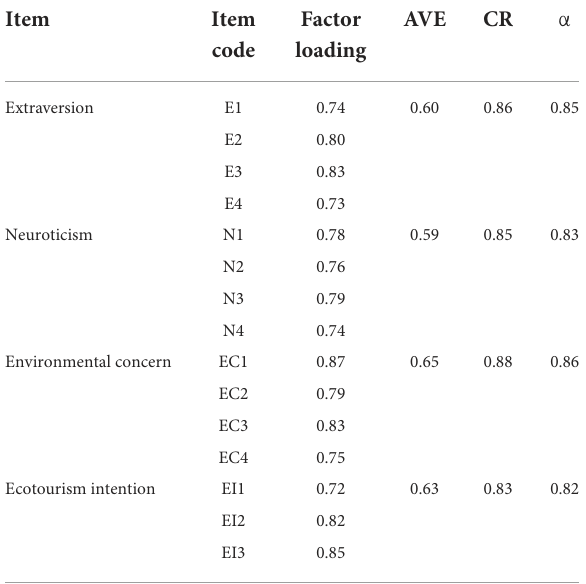
TABLE 1 Reliability and convergent validity.